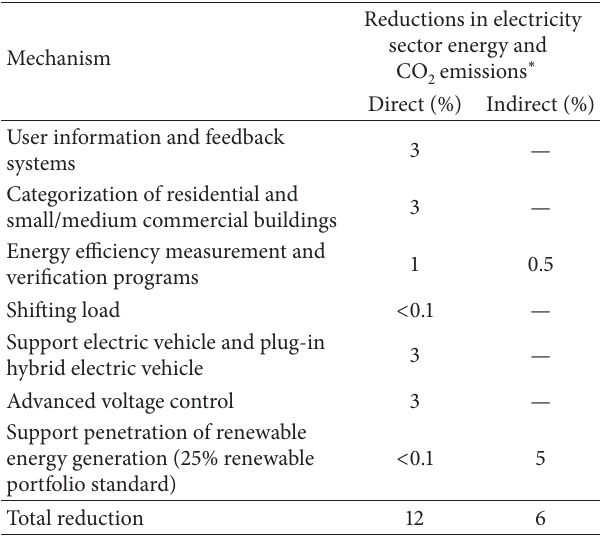
Table 6: Potential reductions in electricity and CO 2030 attributable to smart grid technologies